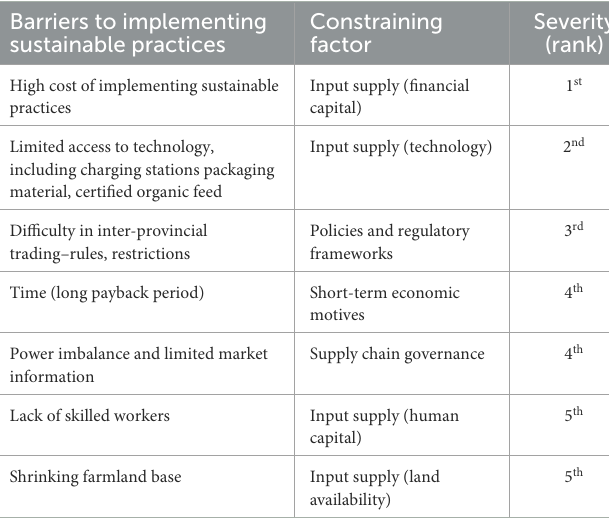
TABLE 7 Barriers preventing the implementation of sustainable